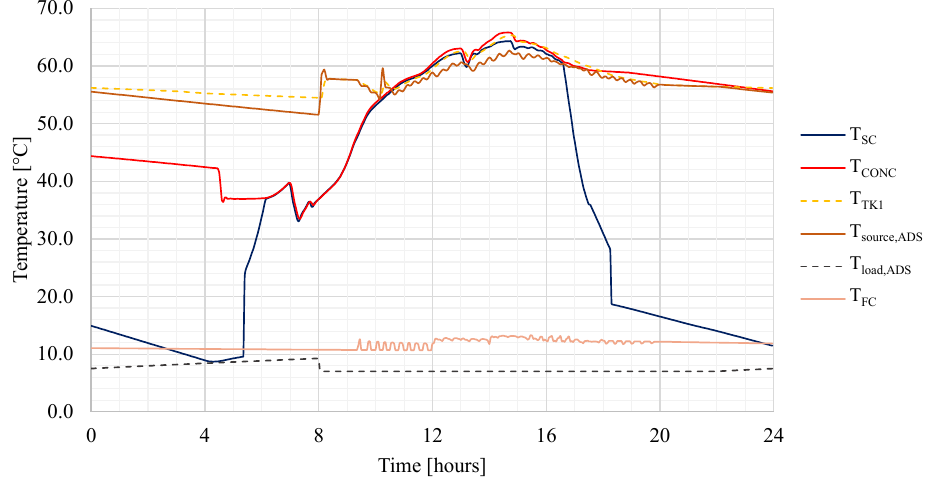
Figure 7. Temperatures at the outlet of the main components, summer day.